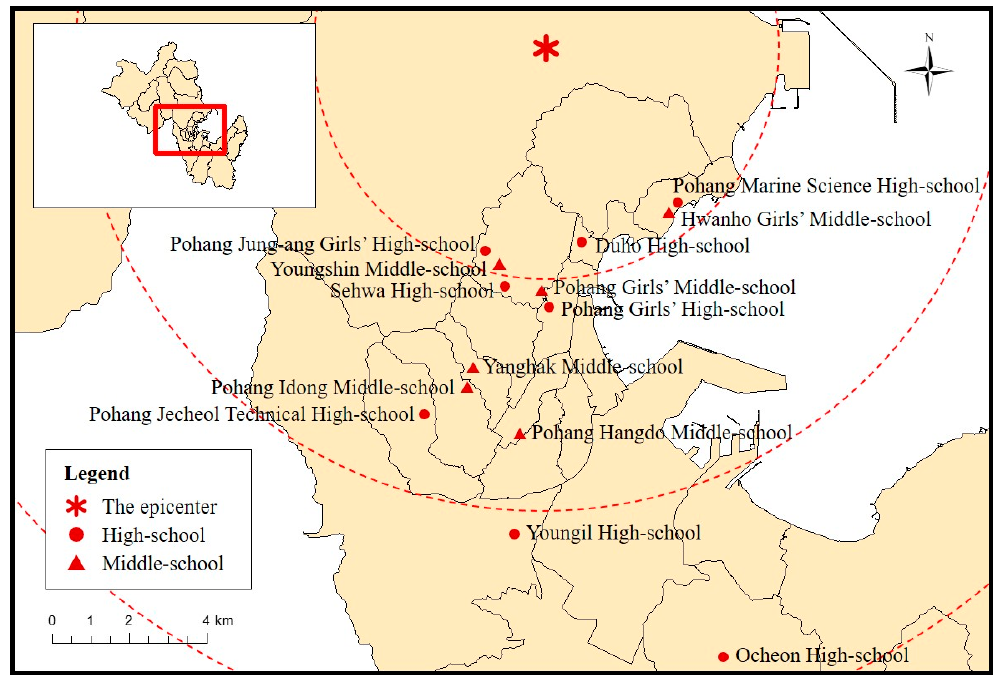
Figure 2. Location of the Epicenter (asterisk) and Schools Participating in the Educational Program (circle and triangle).